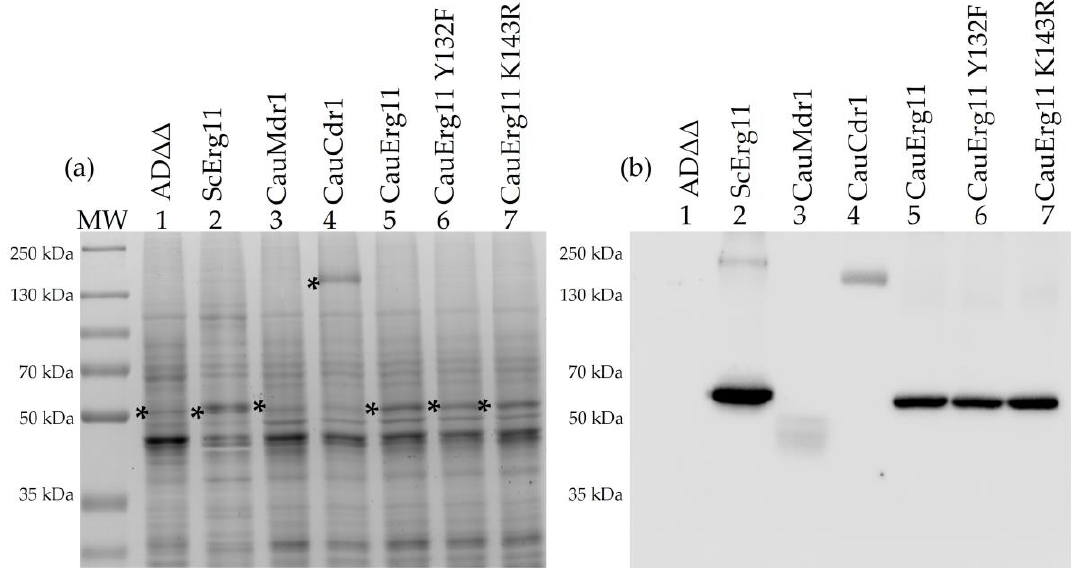
Figure 1. SDS-PAGE and corresponding Western blot of crude membrane preparations from recom- binant strains. ( a ) Coomassie-Blue-stained SDS-PAGE of 20 µg crude membranes expressing recom- binant C. auris Erg11, Mdr1, and Cdr1 proteins. Bands of interest are marked with an asterisk. ( b ) Western blots of 20 µg protein/lane decorated with mouse anti-6×His antibody and visualized using ECL. Lanes: (a, b) 1. ADΔΔ (Y1857), 2. ScErg11 -6×His (Y941), 3. CauMdr1-6×His (Y2765), 4. Cau- Cdr1-6×His (Y2766) 5. CauErg11-6×His (Y2767), 6. CauErg11 Y132F-6×His (Y2768), 7. CauErg11 K143R-6×His (Y2769). MW: 5µL protein molecular-weight markers (PageRuler Plus Prestained Pro- tein Ladder, Thermo Fisher Scientific, Waltham, MA, USA).